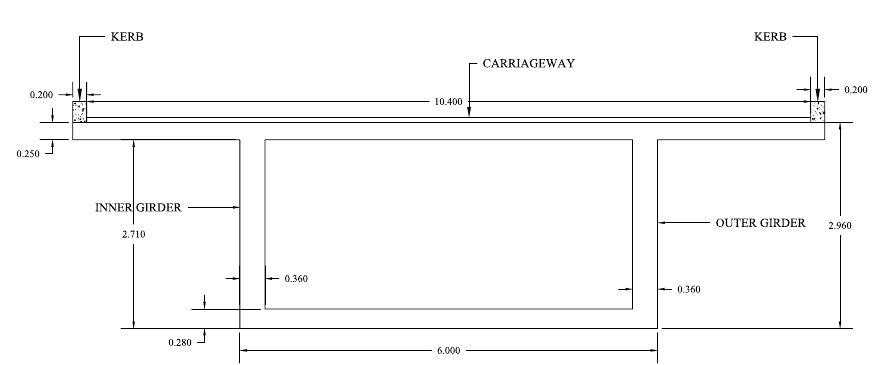
Fig. 2 Validation model of box-girder bridge